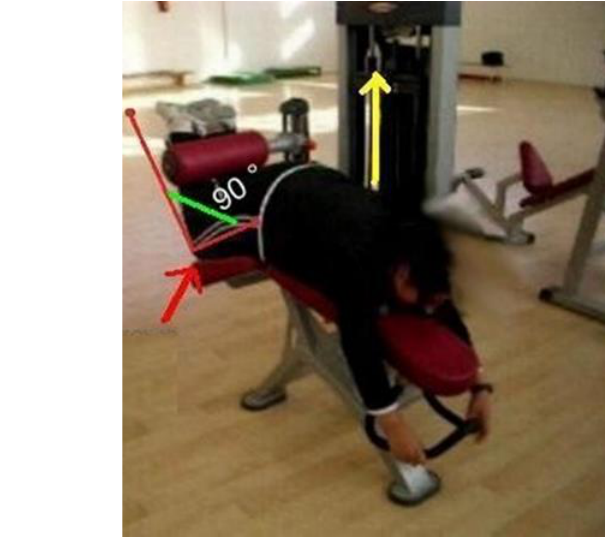
Figure 2. 1-RM prediction of knee flexor